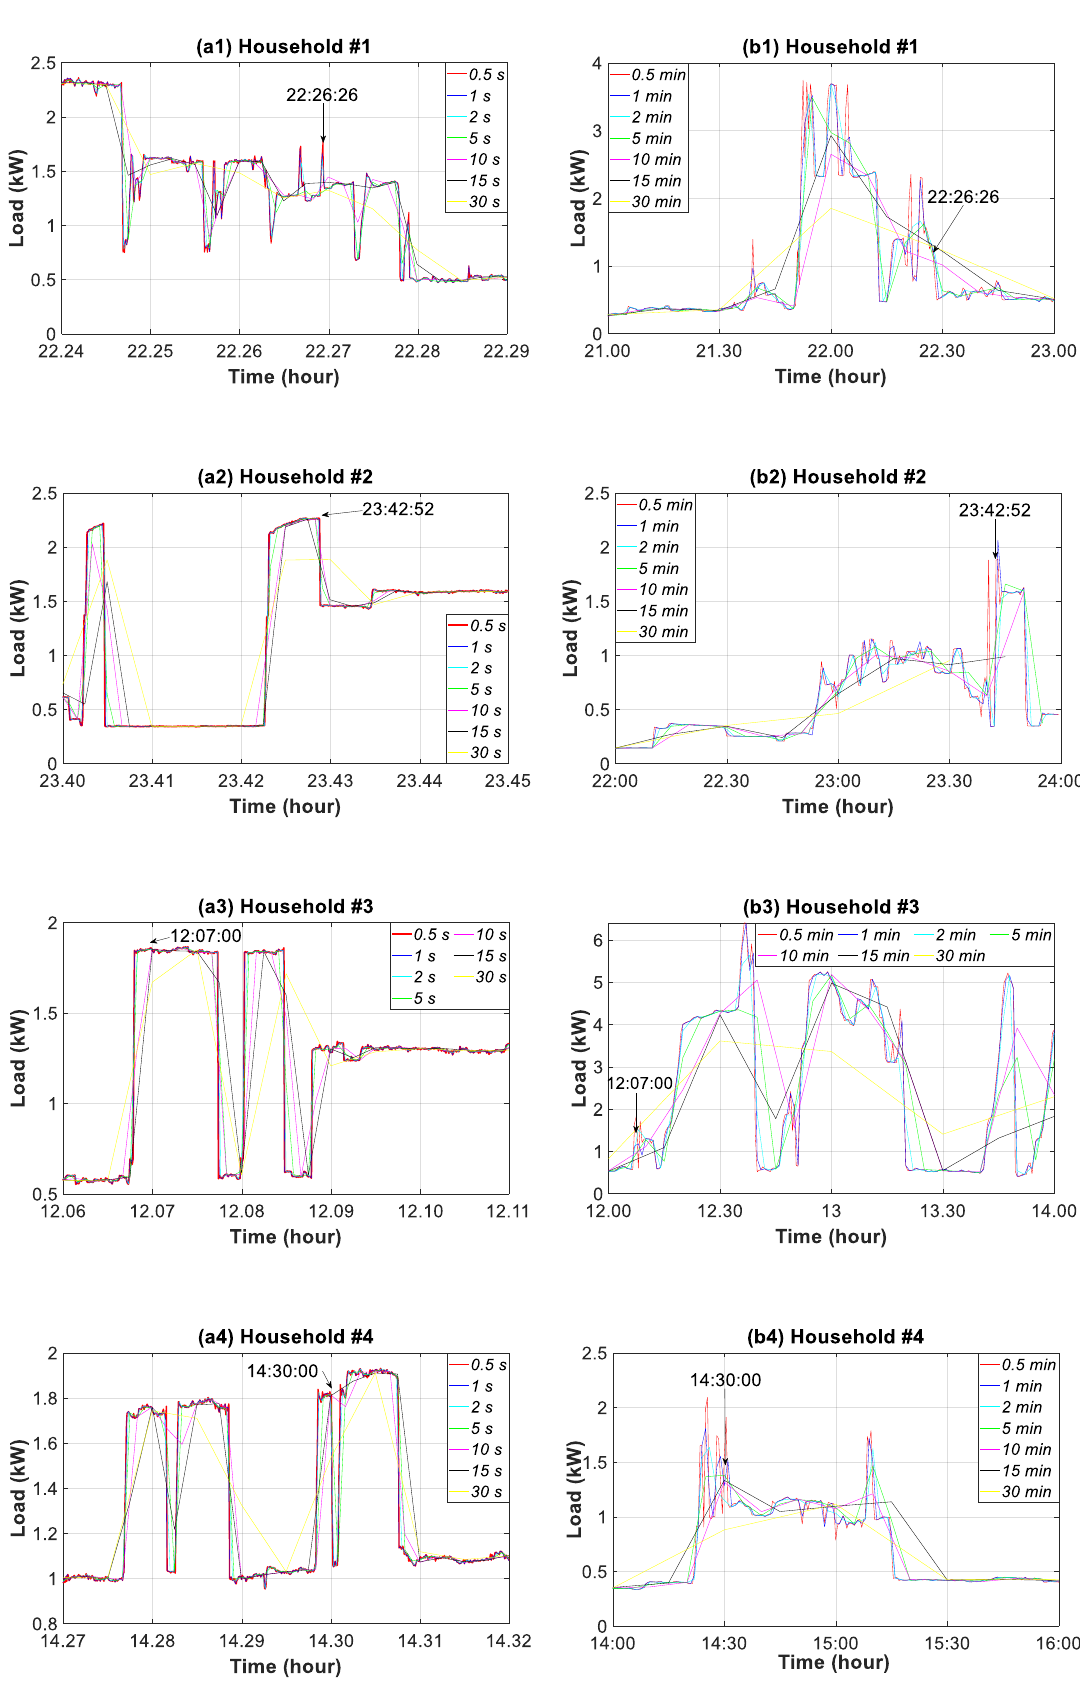
Figure 7. Consumption load profile for household #1 to #4: ( a1 – a4 ) 0.5 to 30 s granularities (5-min timespan); ( b1 – b4 ) 0.5 to 30-min granularities (2-h